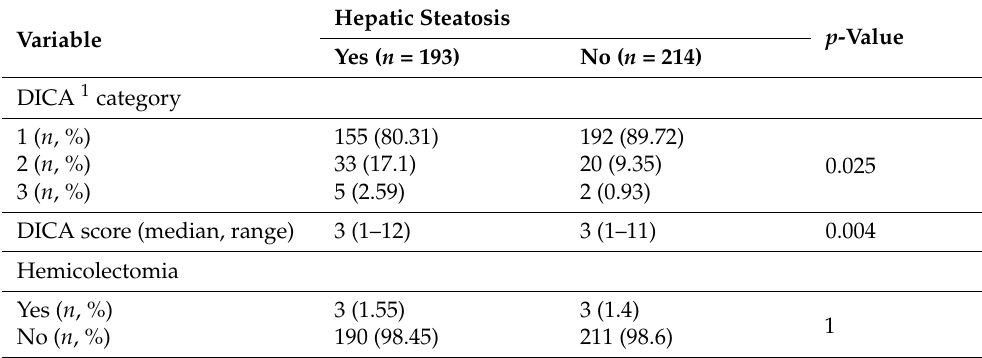
Table 3. Hepatic steatosis and colonic diverticulosis disease